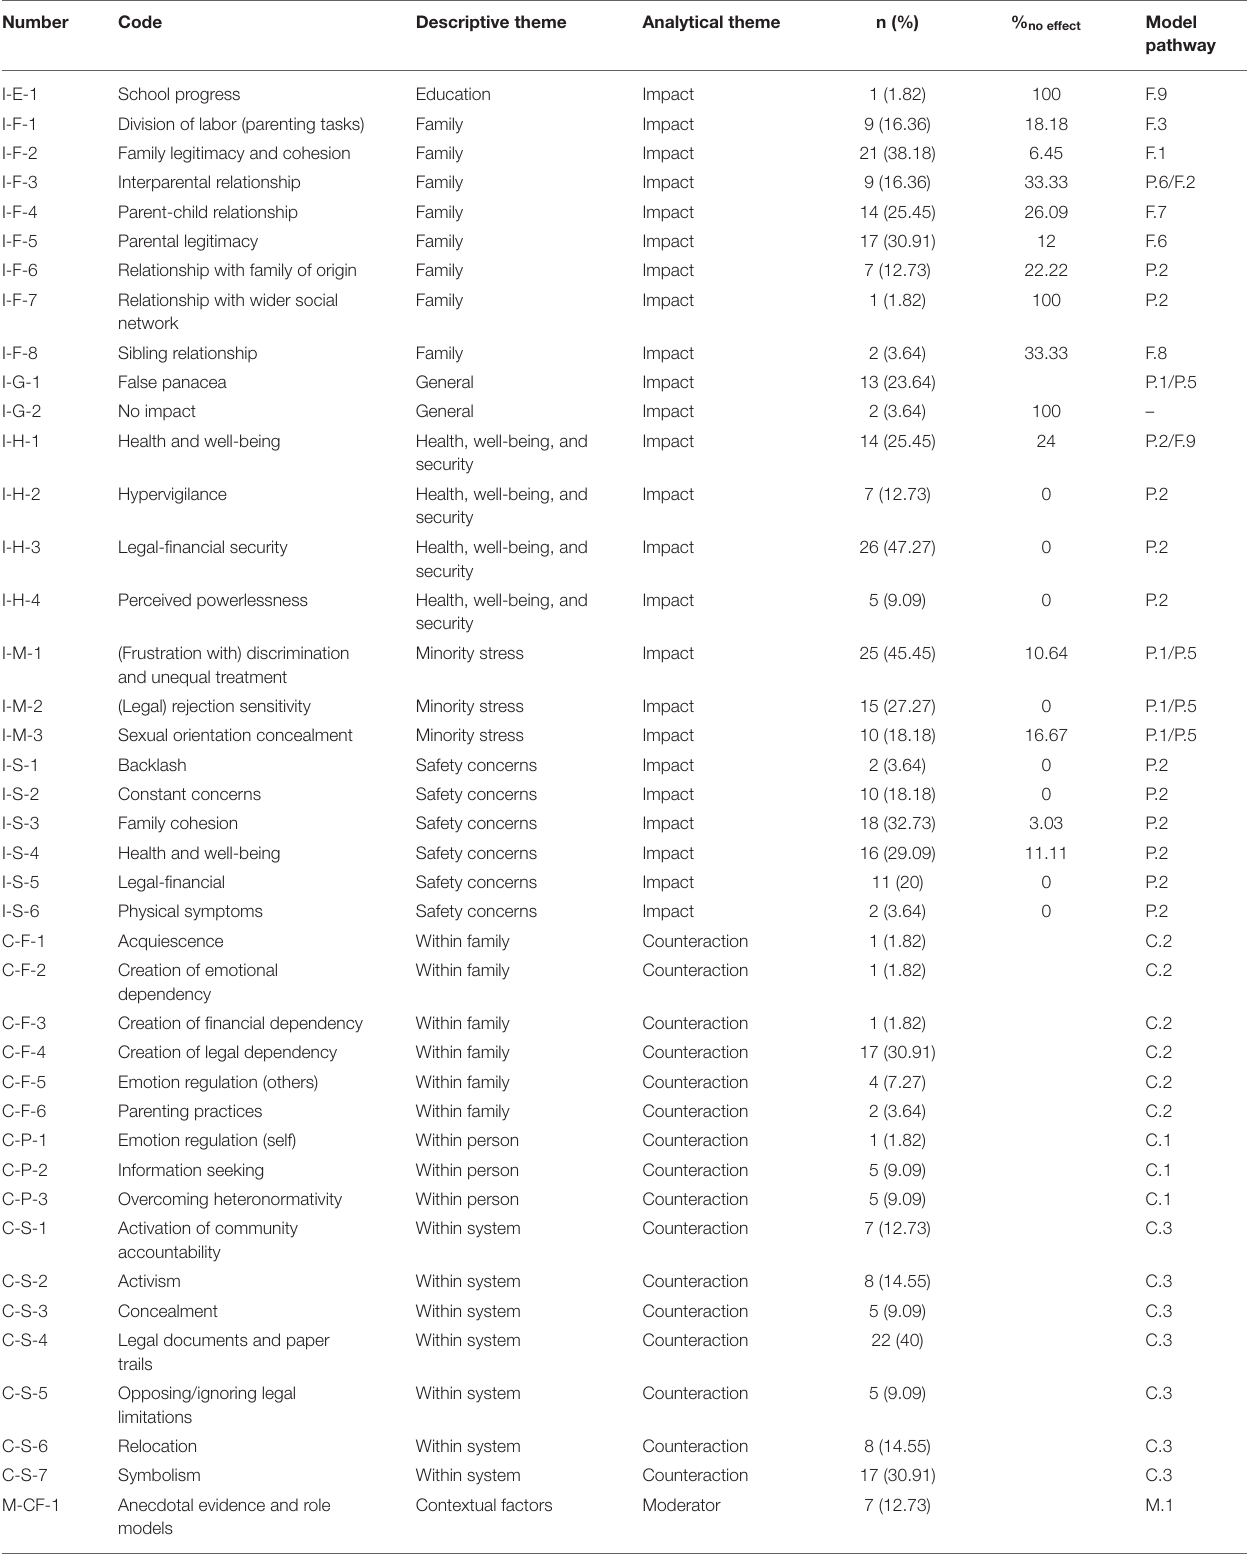
TABLE 4 | Frequencies of assigned codes across studies as well as corresponding descriptive and analytical themes and model